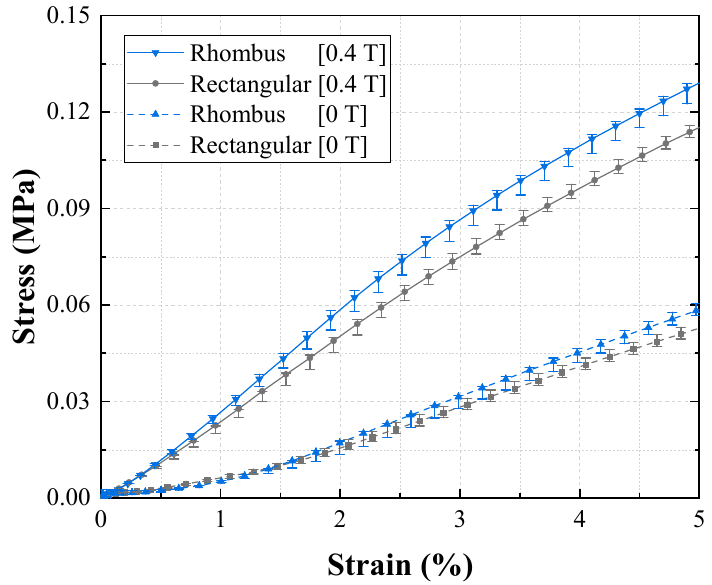
Figure 10. Effect of the channel pattern of the lower MRE layer on Young’s modulus.